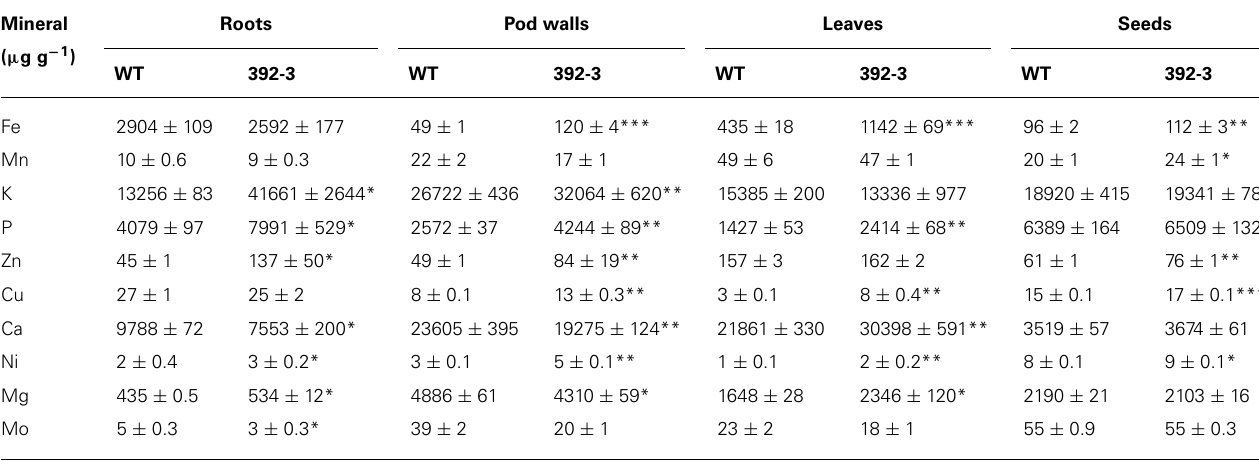
Table 2 | Mineral concentration ( μ g g − 1 ) in roots, pod walls, leaves, and seeds of wild-type (WT) and transgenic 392-3 soybean plants grown in hydroponic conditions with 100 μ M Fe(III)-EDDHA until full maturity (FM).